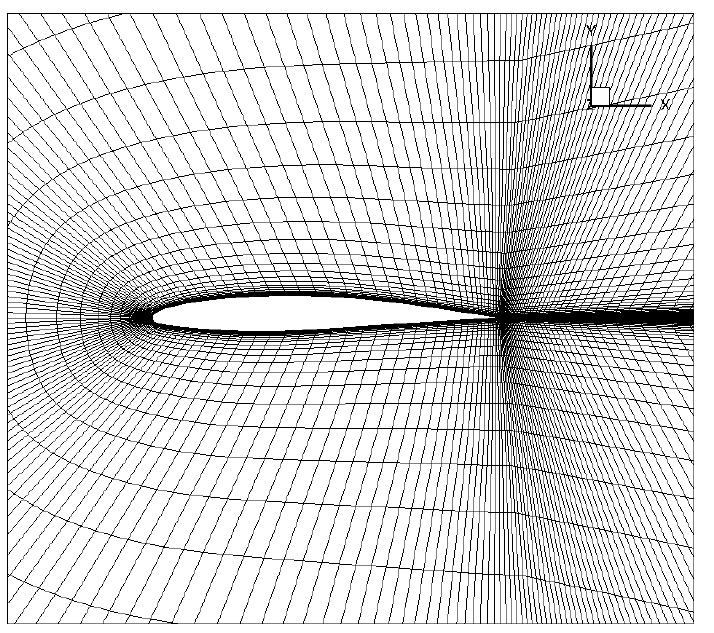
Figure 11. Detail of airfoil